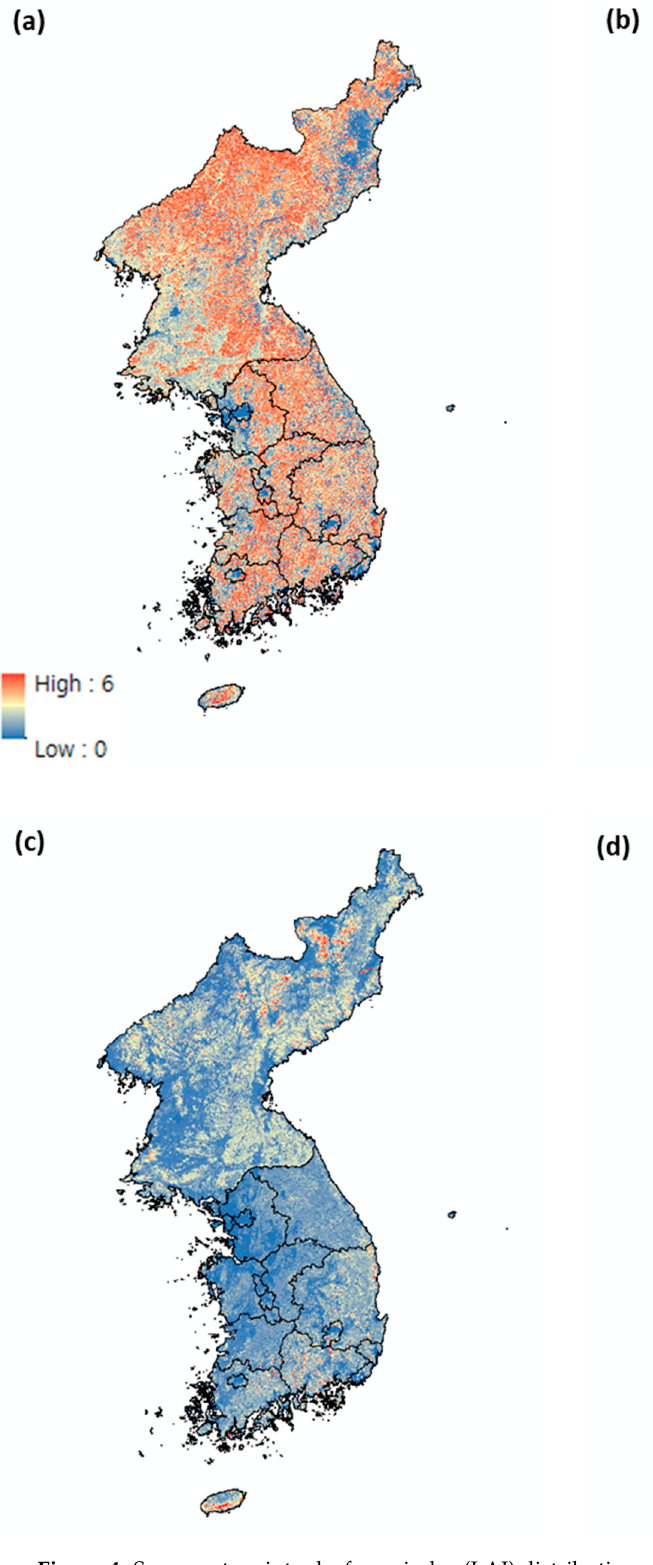
Figure 4. Summer to winter leaf area index (LAI) distributions for the Korean Peninsula, created using: ( a ) Moderate Resolution Imaging Spectroradiometer (MODIS) LAI (August); ( b ) Spatial and Temporal Adaptive Reflectance Fusion Model (STARFM) LAI (August); ( c ) MODIS LAI (December); ( d ) STARFM LAI